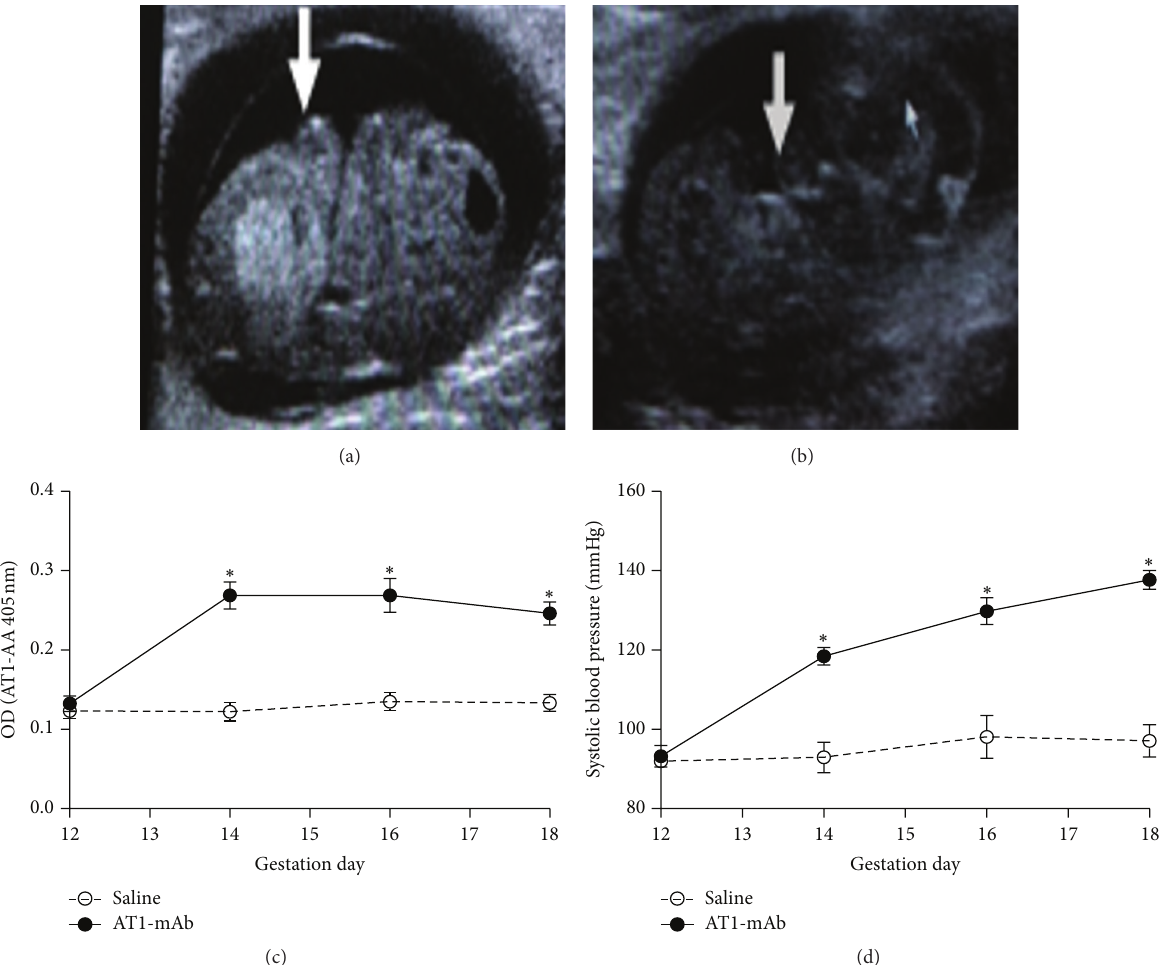
Figure 5: Elevated blood pressure of pregnant mice caused by AT1-mAb. (a) Control group; (b) AT1-mAb group; (c) content of AT1-mAb in sera of mice; (d) systolic blood pressure levels in the pregnant mouse model. ∗ 𝑃 < 0.05 versus saline. Data represent the mean ± SEM; 𝑛 = 6